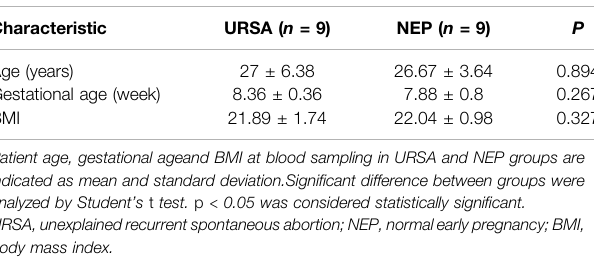
TABLE 1 | Clinical characteristics of the